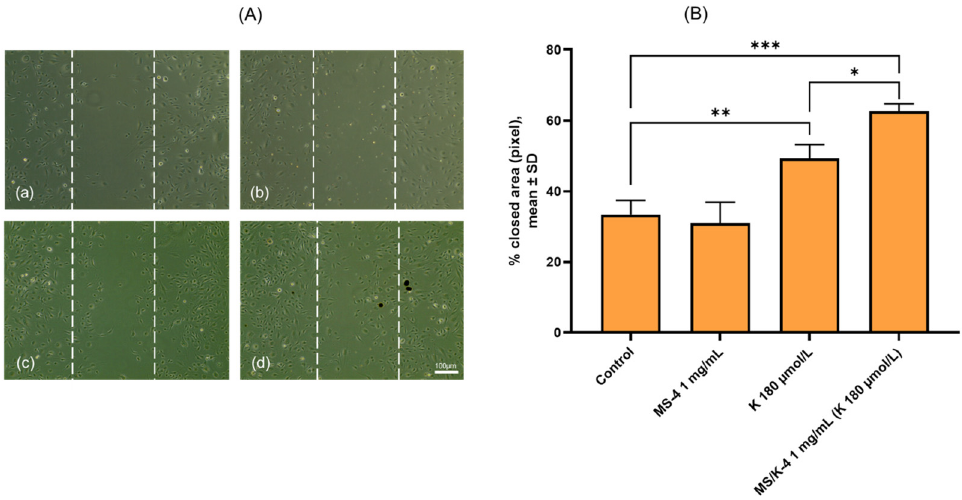
Figure 10. MS/K-4 induced angiogenesis in human endothelial cells. HMEC-1 was treated with MS/K-4, free LYS, or MS-4 for 24 h at the concentrations indicated before vertical scratching of the monolayer. After 24 h, cell migration of ( a ) control, ( b ) MS-4 1 mg/ml, ( c ) LYS 180 μ mol/L, ( d ) MS/K-4 1 mg/ml was observed using phase-contrast microscopy ( A ) and quantified using ImageJ software optimized with specific plugins to automatically detect the scratched area ( B ). Data (mean ± S.D.; n = 3) were expressed as the closed wound area. * p < 0.05 vs. basal (untreated) control; ** p < 0.01 vs. basal (untreated) control; *** p < 0.001 vs. basal (untreated) control.